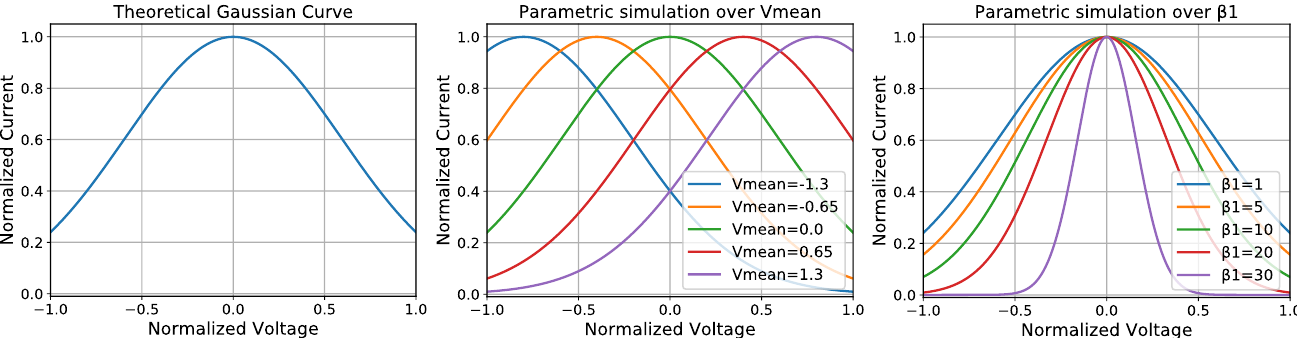
Figure 26. An area-efficient version of Gilbert’s Gaussian circuit.